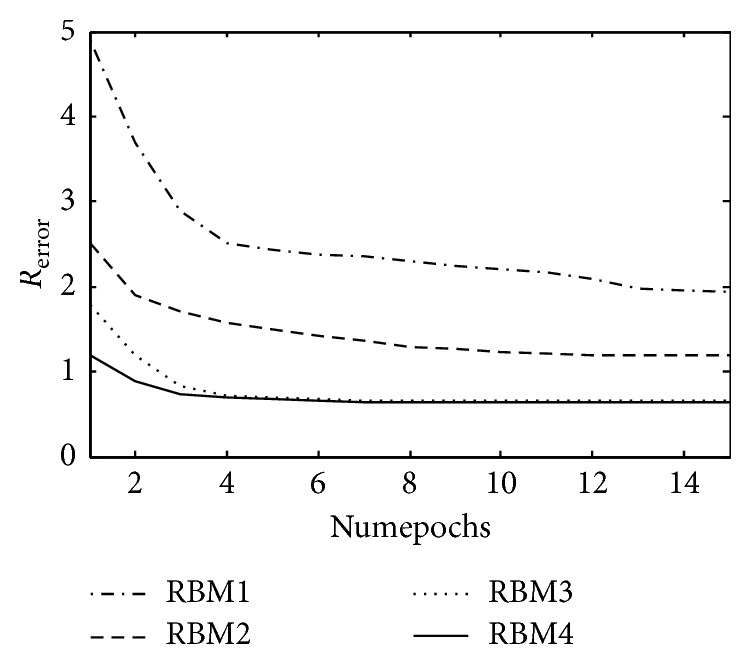
The Rerror curve of each layer RBM on Heart Disease Database.